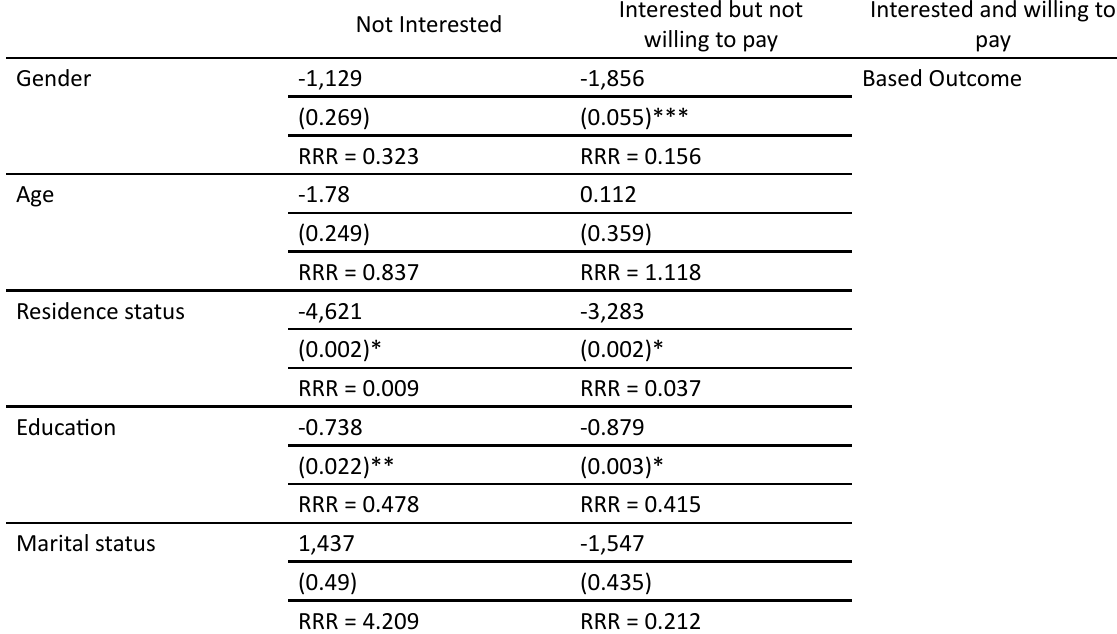
Table 4: Scenario 2: Results of Multinomial Logit Model Estimation Interested but not Interested and willing Not Interested willing to pay